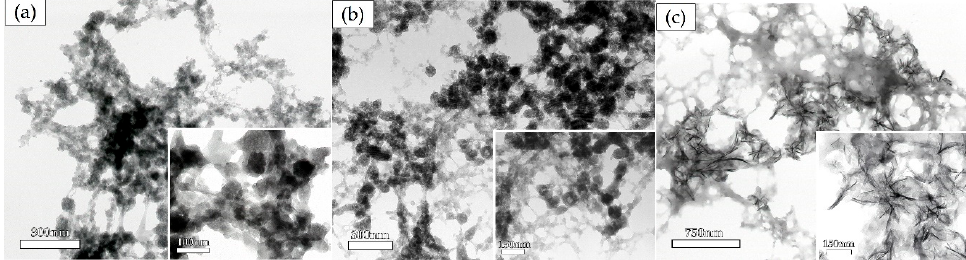
Figure 6. Time course analysis of the crystal shape in the solution containing 0.025% ox-LDL by transmission electron microscopy: ( a ) 5 min; ( b ) 30 min; ( c ) 24 h.